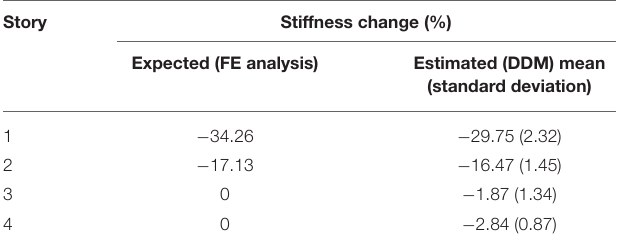
TABLE 5 | Story stiffness change (DC S2).